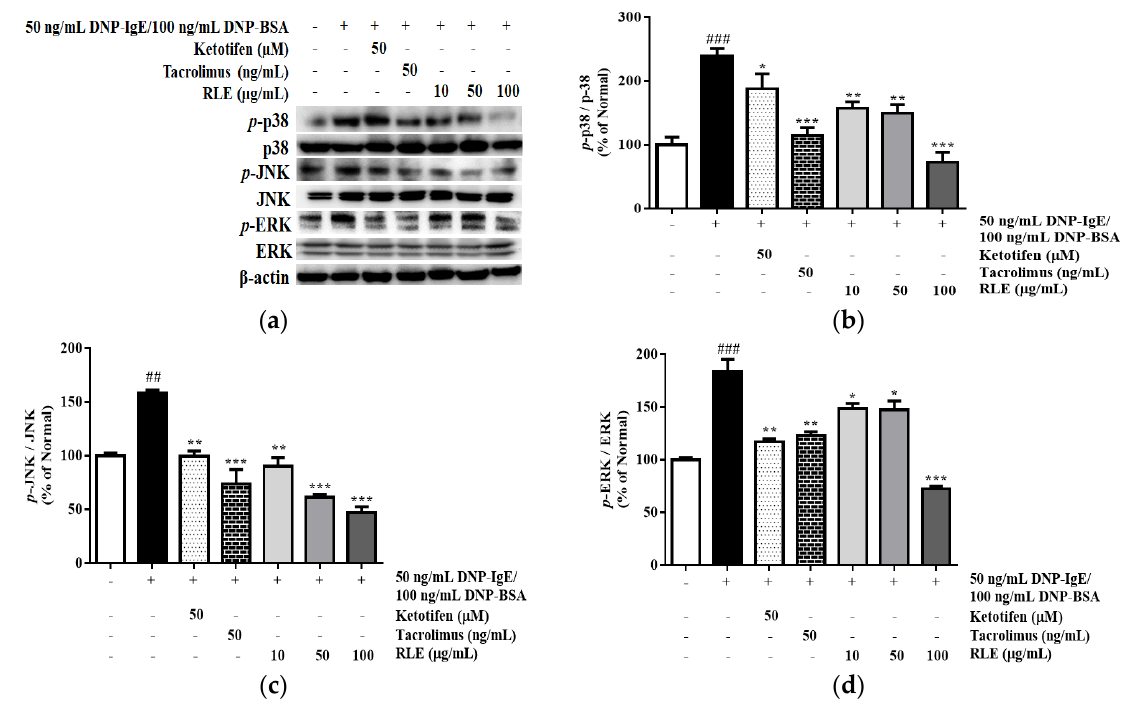
Figure 10. The effects of R. davurica Pall. leaf extract on the protein expression of p − 38, JNK, and ERK from RBL − 2H3 cells. Phosphorylated and non ‐ phosphorylated forms of p − 38, JNK, and ERK were detected by western blot ( a ). The band intensities were quantified by densitometry, normalized to the level of p − 38 ( b ), JNK ( c ), and ERK ( d ) calculated as the percentage of the non ‐ treated group. Data are presented as the mean ± SD. # and * indicate significant differences between the non ‐ treated cells and DNP ‐ IgE/BSA ‐ sensitized groups, respectively. ##, ### p < 0.01, and 0.001 vs. the non ‐ treated group. *, **and *** p < 0.05, 0.01, and 0.001 vs. the DNP ‐ IgE/BSA ‐ sensitized control, respectively.